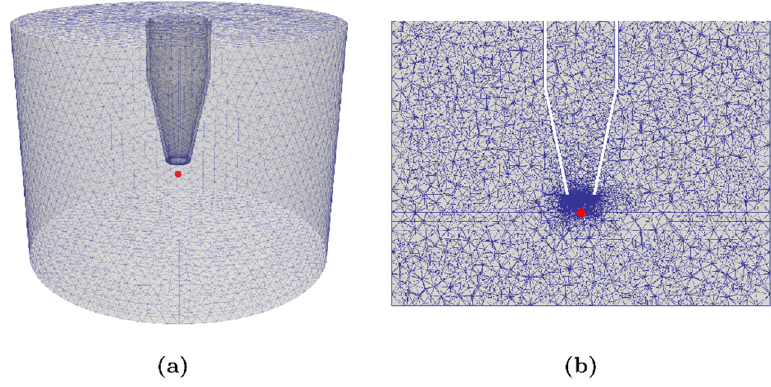
Figure 9. Computational domain of the experimental setup: the complete geometry ( a ) and a cross section ( b ).